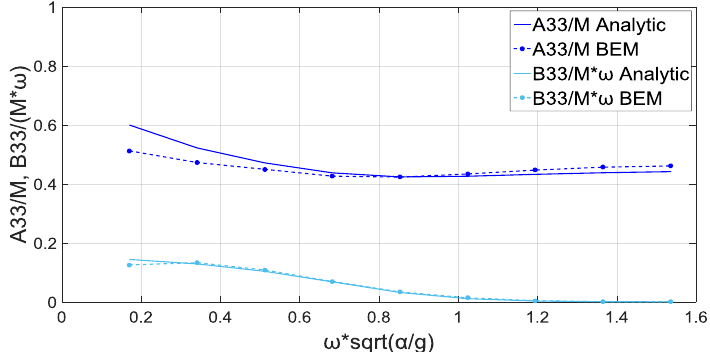
Figure 6. Non-dimensionalized cylinder hydrodynamic coefficients for various values of non- dimensionalized frequency. Cylindrical WEC with /